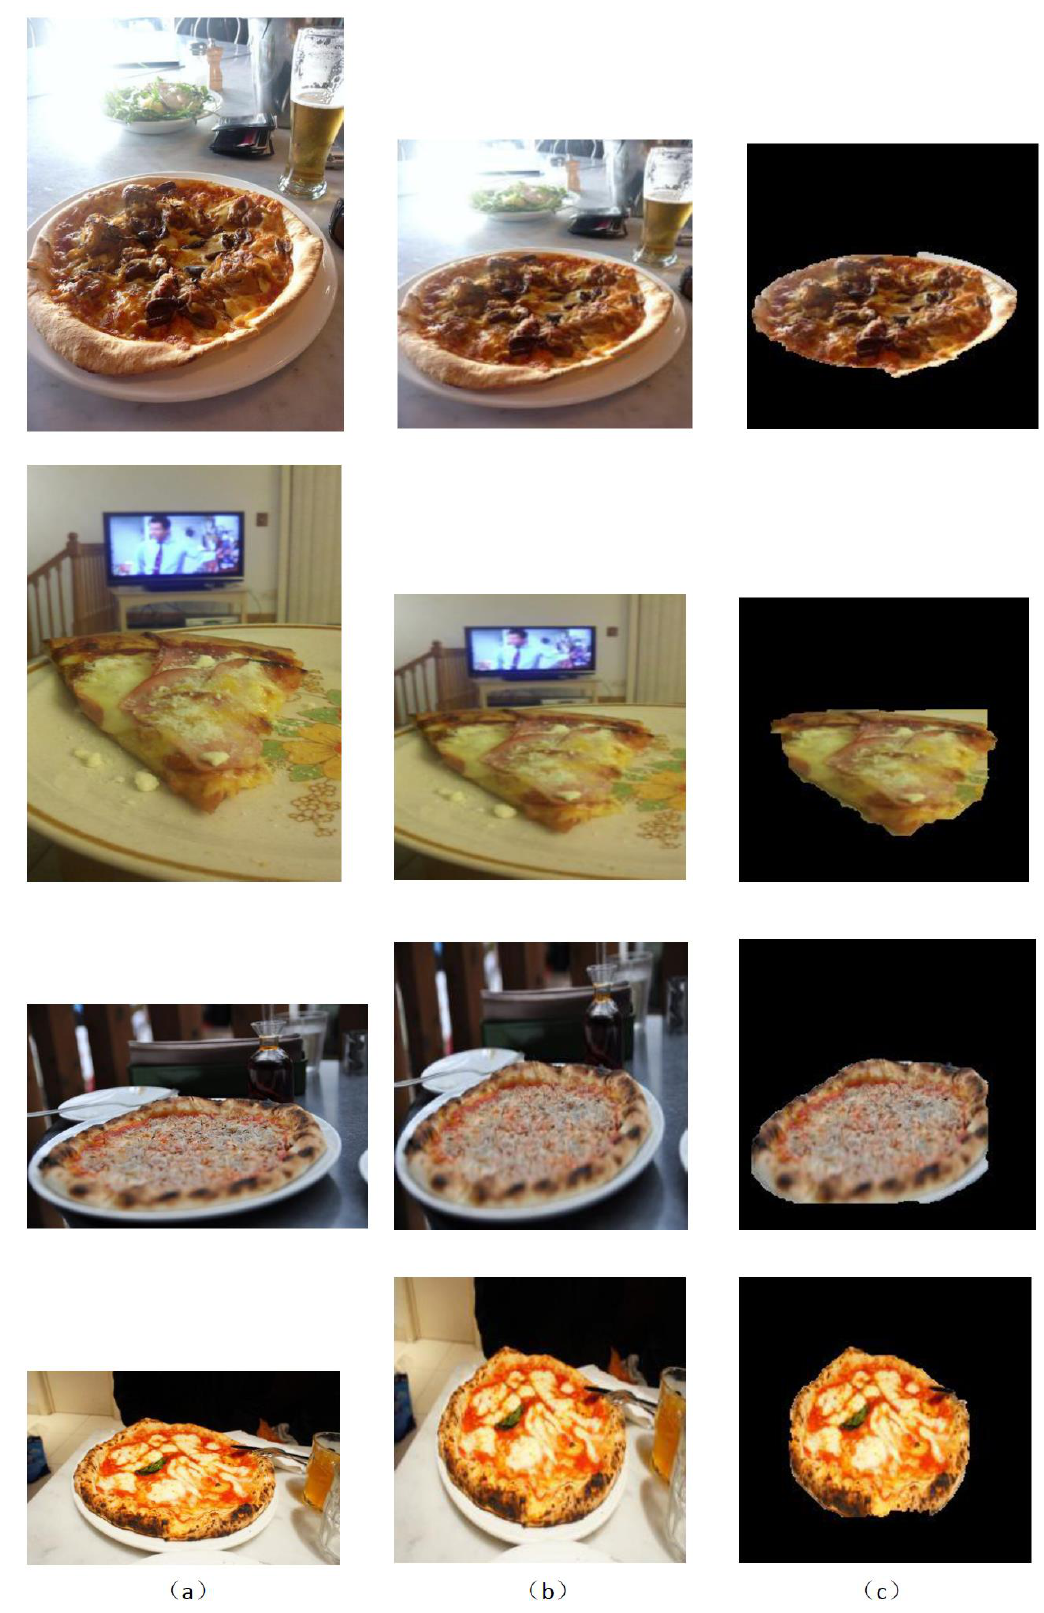
Figure 11. GrabCut-based segmentation experiment results for pizza objects in COCO dataset: ( a ) original input image; ( b ) image after resizing; ( c ) GrabCut method segmentation results.